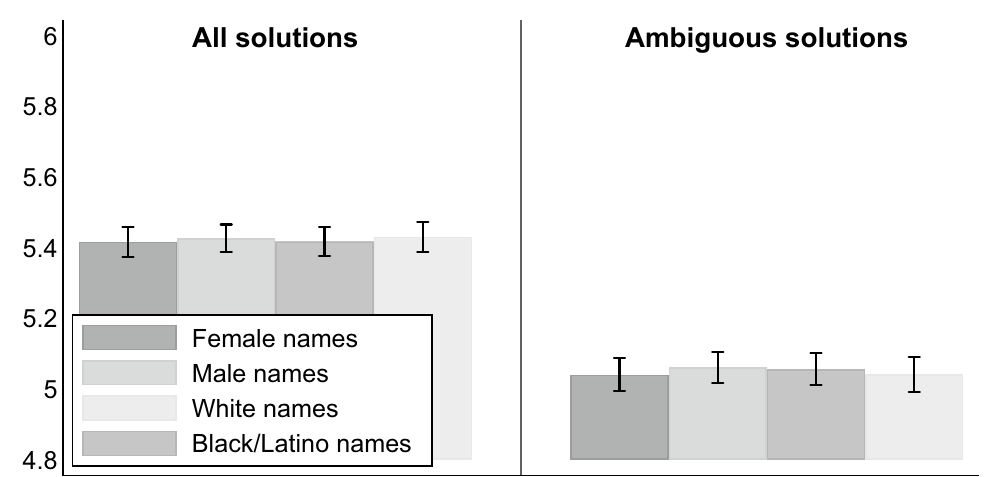
Fig. 3 Mean effort ratings for student solutions by level of correctness, gender, and race of student names. Heteroskedastic‑robust standard errors clustered on teachers appear as bars around the mean estimates. Models also include controls for item and item positioning on the